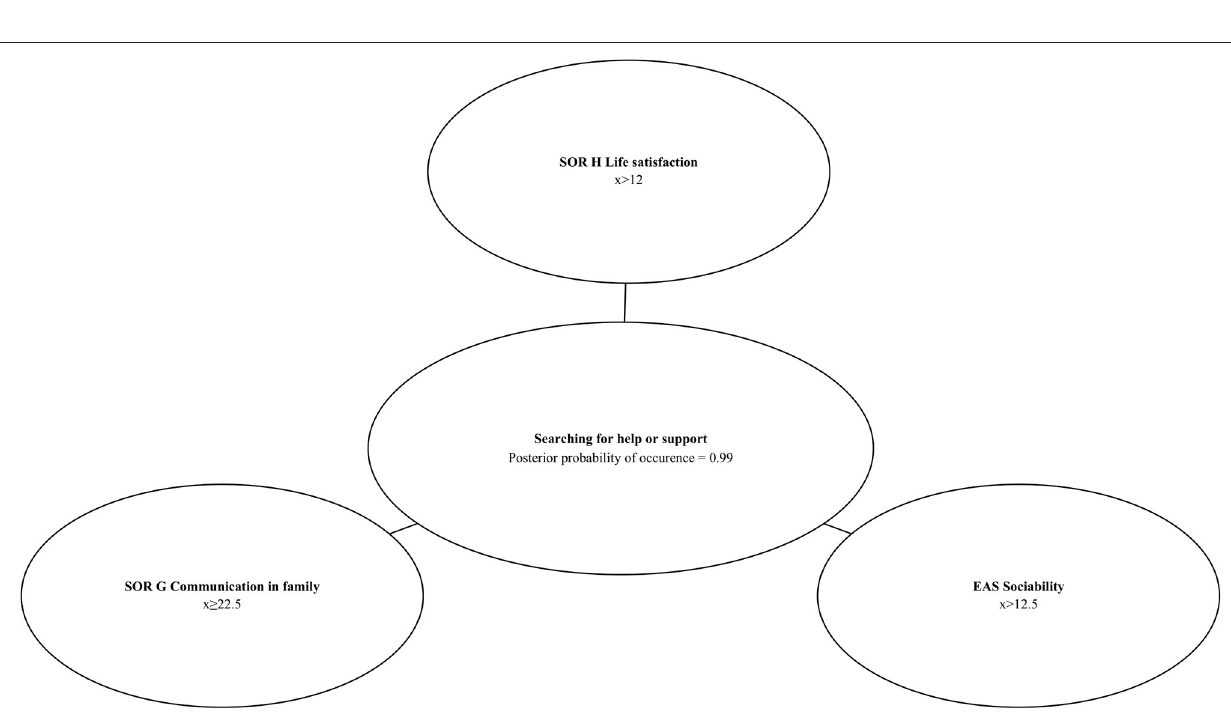
Frontiers in Psychiatry |